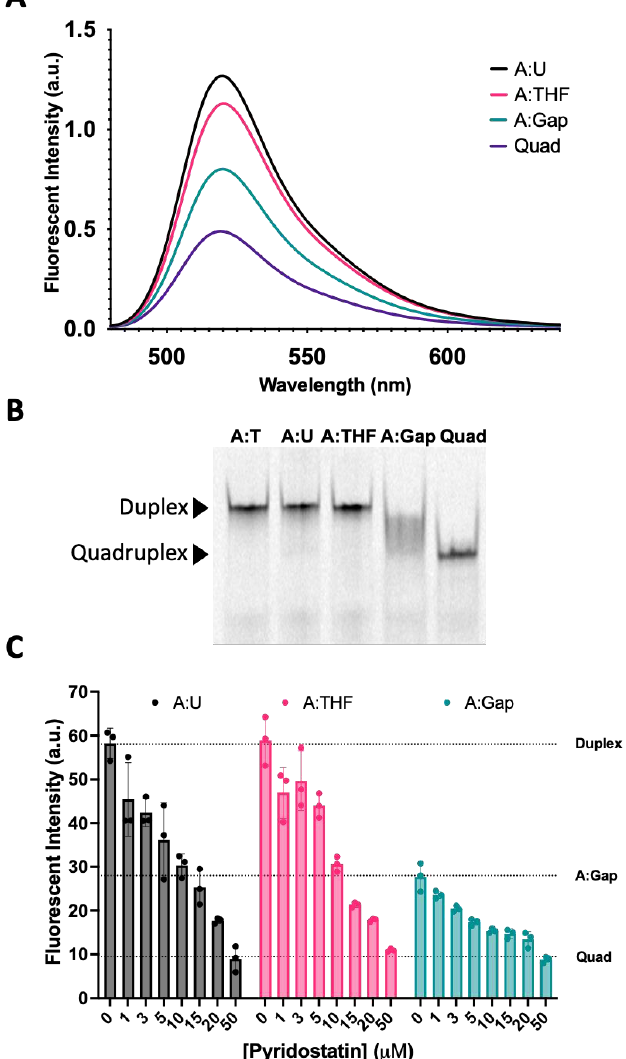
Figure 5. Reconstitution of repair intermediates promoted quadruplex formation. ( A ) Annealing Tel22-T with a complementary strand containing U (A:U) promoted duplex formation as indicated by an increase in fluorescence relative to the quadruplex-only control (Quad). When a complementary strand containing a stable abasic site (A:THF) was used instead, fluorescence was reduced relative to the A:U duplex, suggesting the destabilization of the duplex and promoting quadruplex. Interestingly, generating a gap in the complementary strand (A:Gap) further destabilized the duplex and shifted the equilibrium towards quadruplex. ( B ) Using a 20% native polyacrylamide gel, we demonstrated that A:U and A:THF were duplex as they migrated the same as the A:T control (Lanes 1–3). On the other hand, a gapped complement (A:Gap) showed some intermediate between duplex and quadruplex (Lane 4). Lane 5 was the quadruplex-only control. ( C ) We saw a concentration-dependent decrease in fluorescence when we titrated oligonucleotides that could form a duplex with a quadruplex- stabilizing small molecule, pyridostatin. Consistent with A and B, the A:Gap oligonucleotide had ~50% of the fluorescence as either A:U or A:THF. Oligonucleotides were prepared as a 1 µ M solution in 20 mM Tris, pH 7.4, 150 mM KCl, and 15 mM NaCl and equilibrated in buffer for a minimum of 30 min. 1.2 equivalents of the corresponding complementary strands were annealed at 90 ◦ C for 5 min and cooled at RT. Gel samples were prepared identically. Pyridostatin was allowed to equilibrate with oligonucleotides for 30 min at 37 ◦ C and fluorescence emission of FAM was acquired using a qPCR